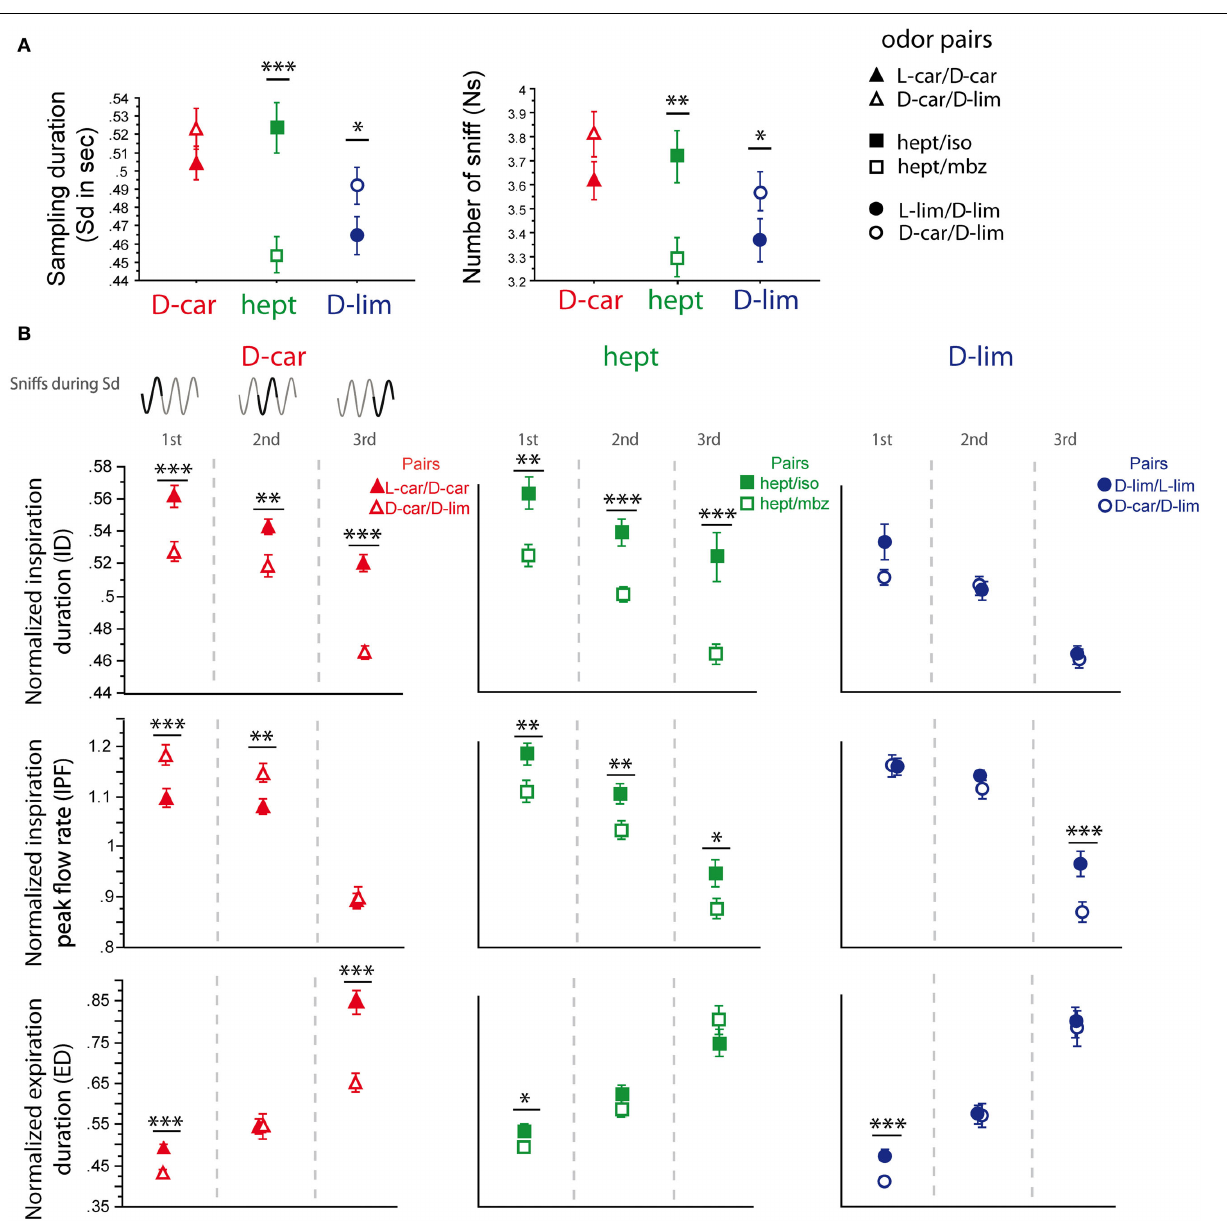
the same odorant presented in two different pairs. Left: D-car in the enantiomer pair or the D-car/D-lim pair; middle: hept in the hept/iso pair or the hept/mbz pair; right: D-lim in the enantiomer pair or the D-car/D-lim pair. From top to bottom: mean ( ± s.e.m.) of the normalized ID, IPF, and ED. The number of trials for each odorant and cycle is: D-car: n cycle 1 = 206, n cycle 2 = 197, and n cycle 3 = 181; hept: n cycle 1 = 155, n cycle 2 = 148, and n cycle 3 = 121; D-lim: n cycle 1 = 206, n cycle 2 = 200, and n cycle 3 = 157. Data were analyzed using a paired t -test; ∗ p < 0 . 05; ∗∗ p < 0 . 01; ∗∗∗ p < 0 .